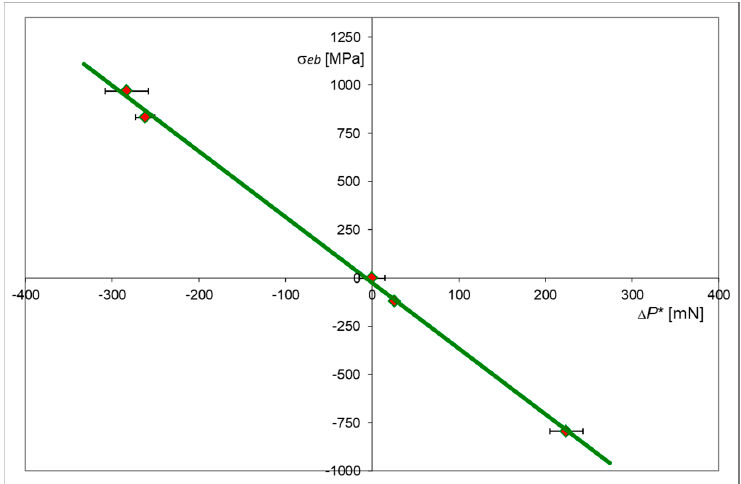
Figure 11. Relationship between equibiaxial stress σ eb and the change in indentation force Δ P * at a constant penetration depth h* = 4 μ m. Annealed X20Cr13 steel. constant penetration depth h* = 4 µ m. Annealed X20Cr13